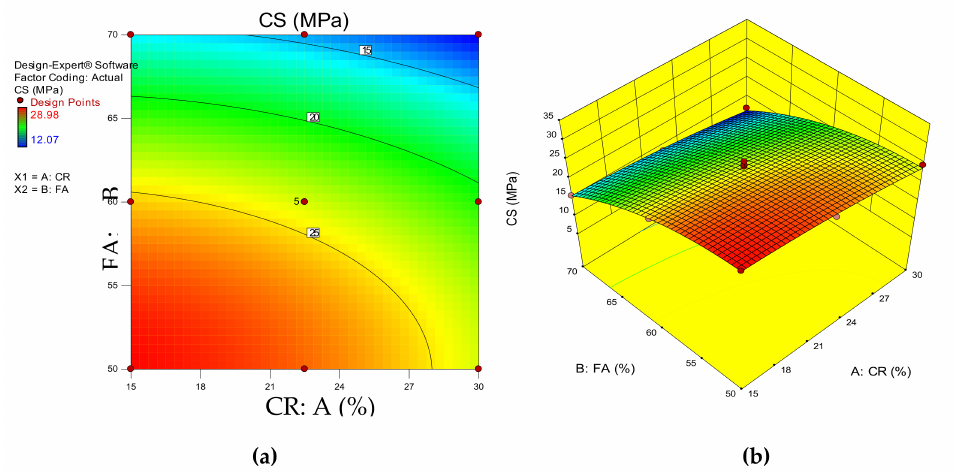
Figure 9. HVFA–CRC 2D and 3D response surface graphs for